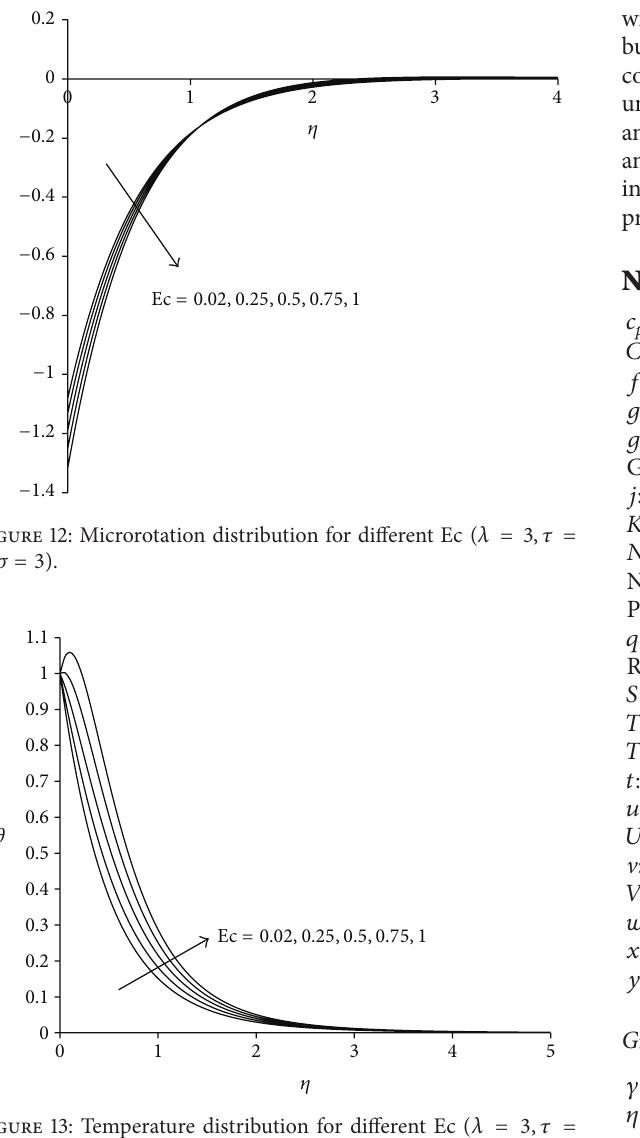
Figure 13: Temperature distribution for different Ec (𝜆 = 3, 𝜏 = 1, 𝜎 = 3)